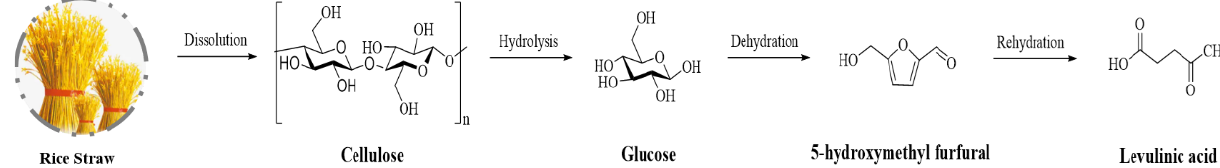
Figure 2. Reaction pathway of levulinic acid synthesis from lignocellulose.